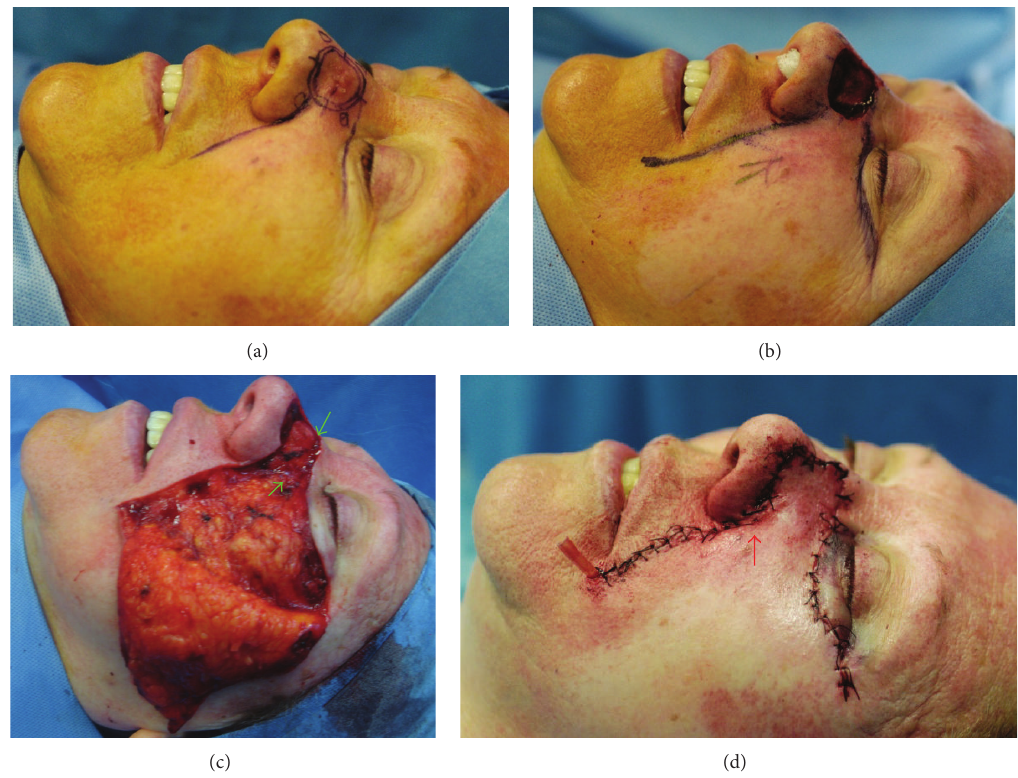
Figure 1: Patient no. 2 showed in Table 1. (a) Basal cell carcinoma of the left nasal sidewall and dorsum marked for the excision; (b) 2.6 × 2.8 cm defect after tumor resection. Advancement cheek flap designed with inferior incision outlined in the nasofacial sulcus and melolabial crease and superior incision placed in the inferior bony orbital rim. (c) Flap elevated from the medial border in a subcutaneous plane. Green arrows indicate the placement of the two adsorbable anchor sutures. (d) Intraoperative final result. Red arrow indicates the Burow’s triangle excised from the inferomedial aspect of the flap to recreate alar-facial sulcus.